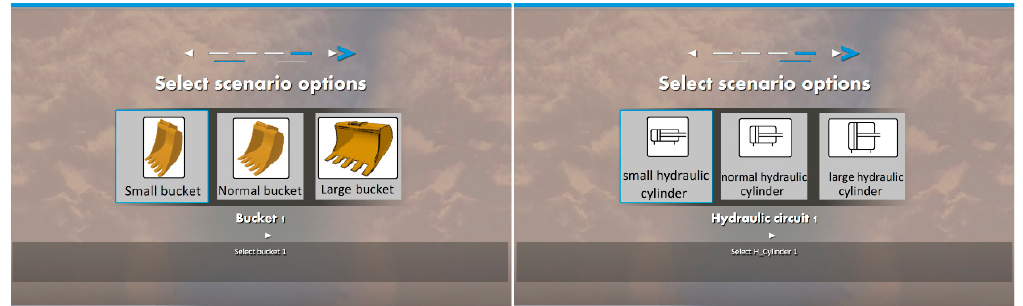
Figure 5. Graphical user interface for bucket and hydraulic-circuit selection.